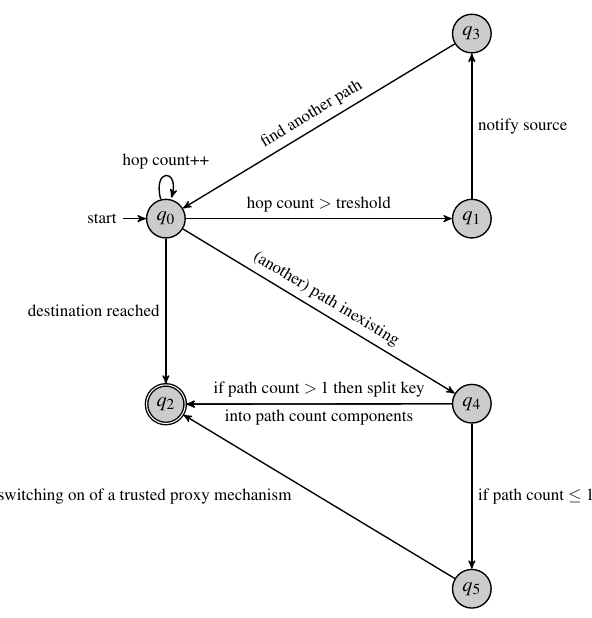
Figure 2. A threshold in the number of hops should prevent packet overhead; switching to a trusted proxy (see subsection 3.3) in unsuccessful cases.